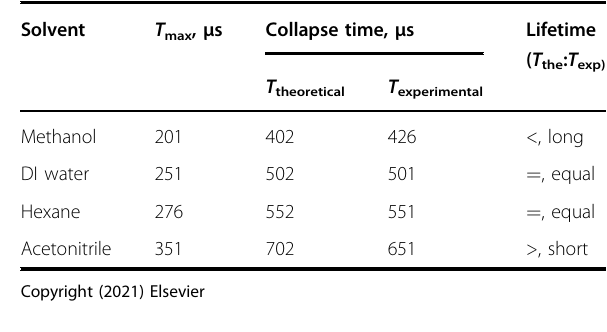
Table 2 Time-evolution dynamics of LICB lifetime obtained for the PLA of the Ni plate for 30 min in